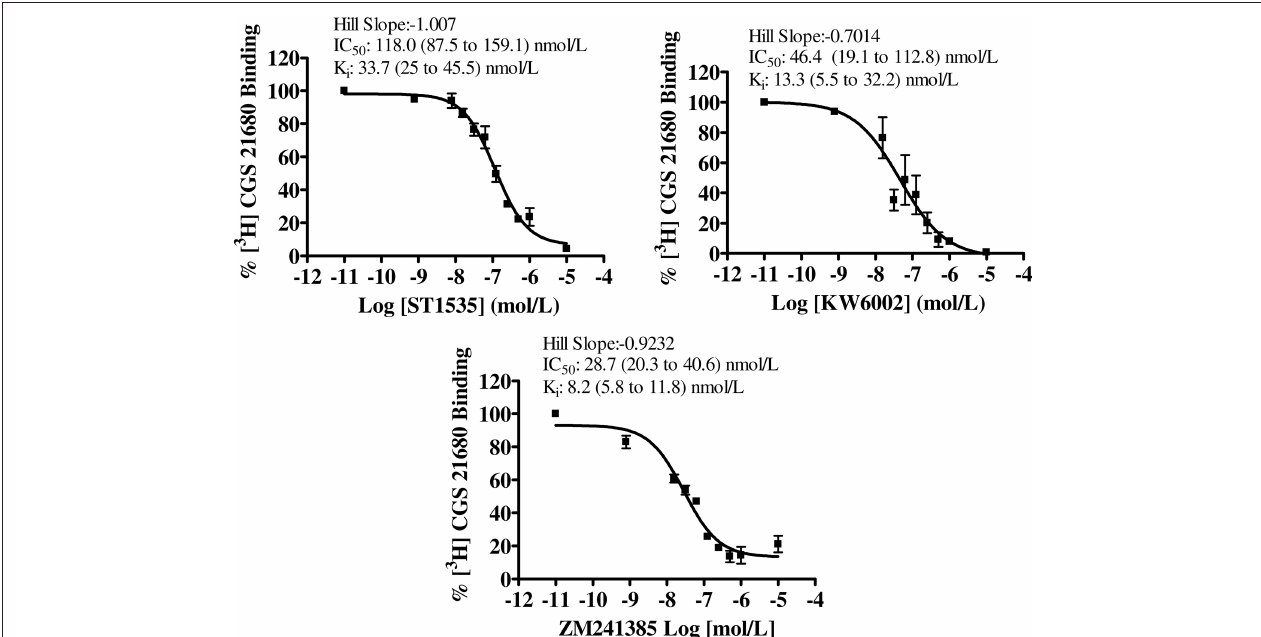
concentrations of compounds and a fixed saturating concentration of DPCPX. FiGure 2 | Dose–response curves of compound-mediated displacement of Non-specific binding was determined with 100 μM 2-chloroadenosine. Curves [ 3 H]CGS21680 binding to rat striatum in the presence of 100 nmol/L were obtained from three independent experiments performed in duplicate. DPCPX, to isolate typical adenosine A receptors. The ordinates represent 2A Values in brackets represent 95% confidence intervals. the specific binding of 30 nmol/L [ 3 H]CGS21680 in the presence of different